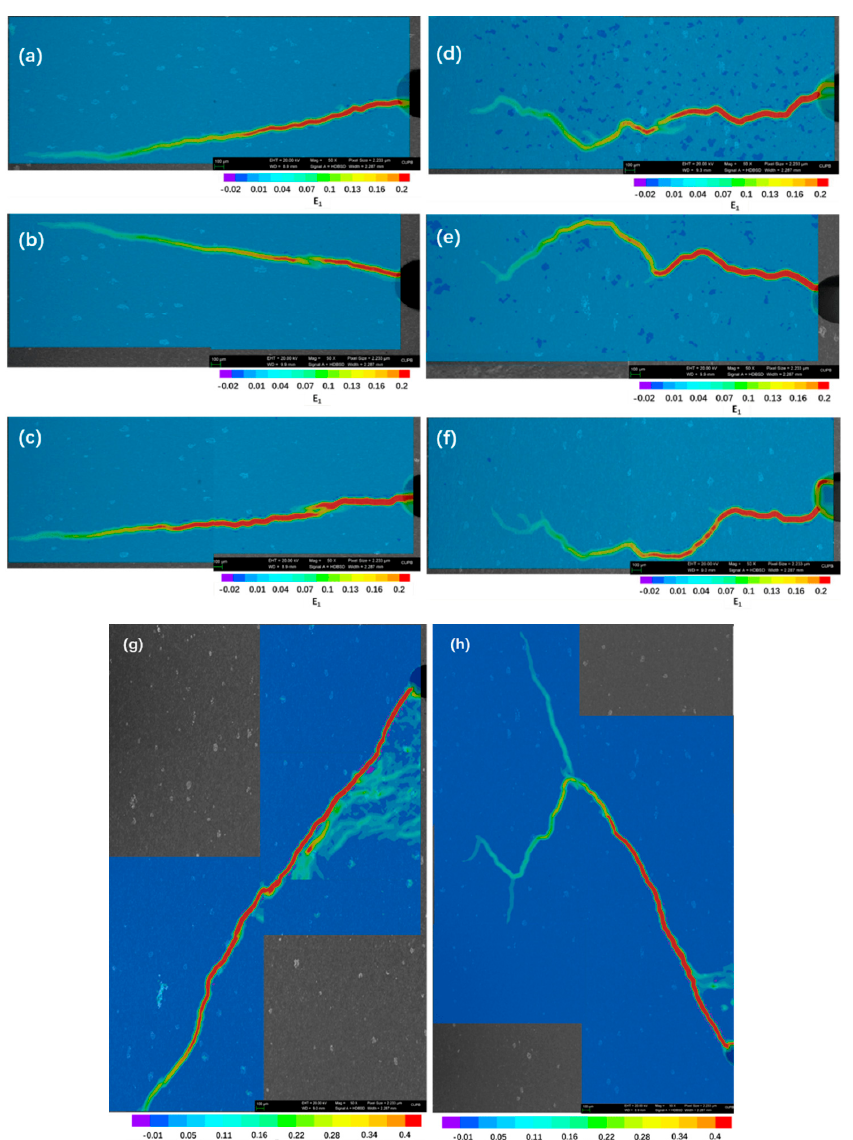
Figure 10. Crack paths in the three-point bending experiment: ( a – c ) are type − ST crack cases; ( d – f ) are type − D crack cases; and ( g , h ) are type − A crack